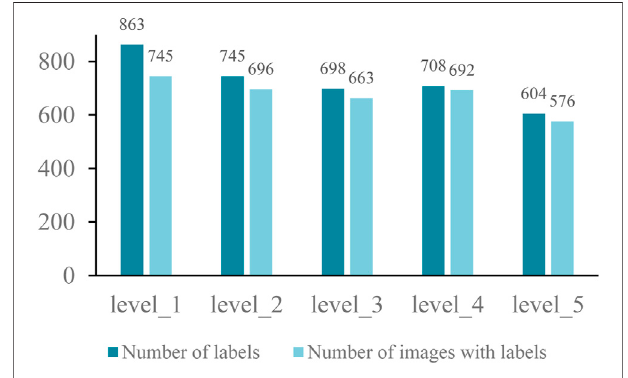
FIGURE 11 | Label and image distribution of various insulator icing levels in the training set.